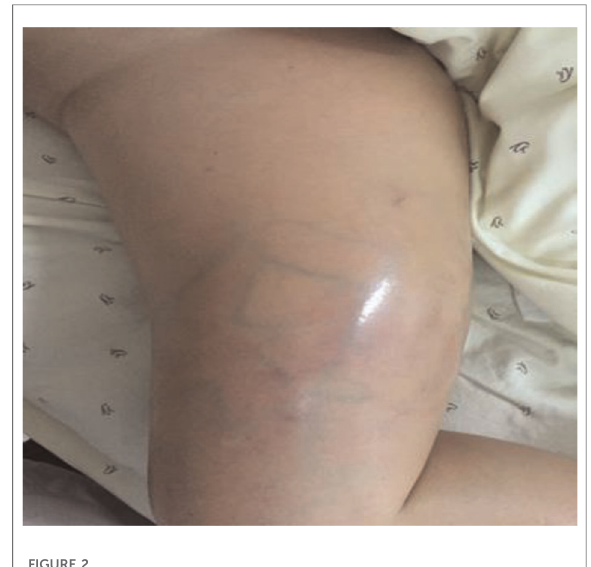
FIGURE 1 The tumor invaded nerve tissue (HE staining, 400×).